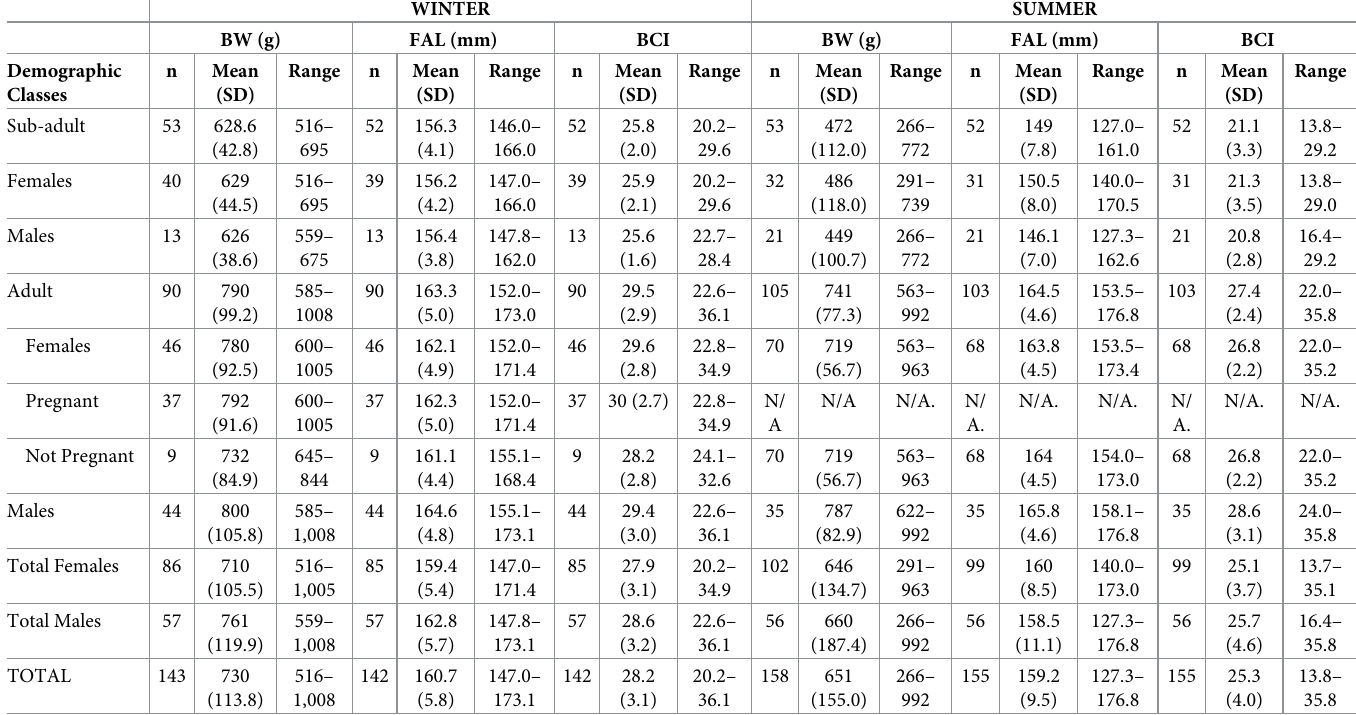
Table 2. Summary demographic statistics–winter versus